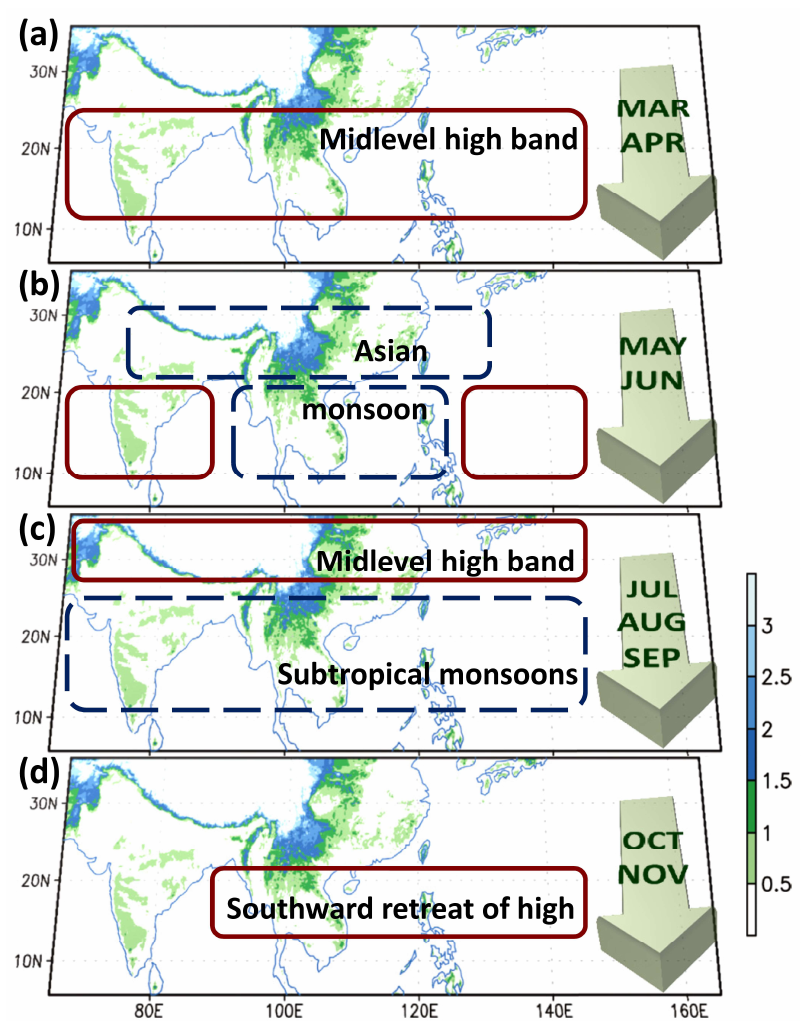
Figure 13. Schematic of seasonal evolution (spring to autumn) of the subtropical circulation in the Asian–Pacific monsoon region. Color shadings denote elevation (unit: km). See illustration in the text.